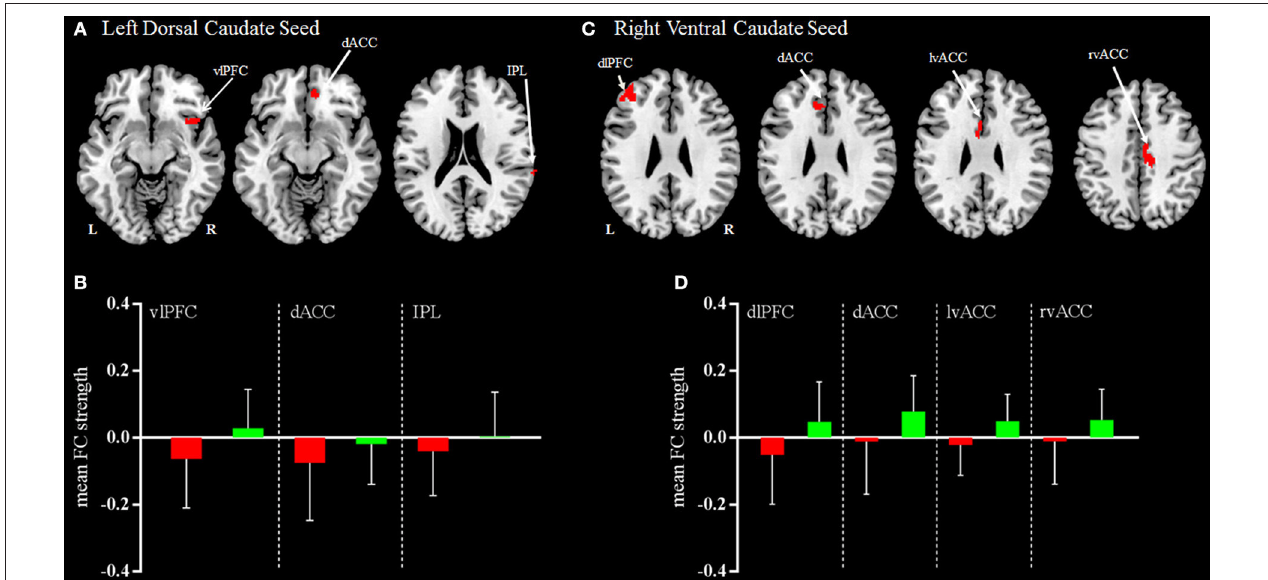
FIGURE 3 | Regions demonstrating group differences in mean FC (functional connectivity) strength for the left dorsal caudate seed (A) and right ventral caudate seed (C) at acute phase. Red coloring indicates regions where the functional connectivity strength was significantly decreased for patients with mild TBI, compared with HC. The bar charts display mean functional connectivity strength between selected significant regions within the left dorsal caudate seed (B) and right ventral caudate seed (D) above for mild TBI (red) and HC (green). Error bars illustrate standard deviations of the mean. Coordinates for slice locations are presented according to the MNI atlas, and cluster volumes are presented in Table 3 . L,Left; R,Right.